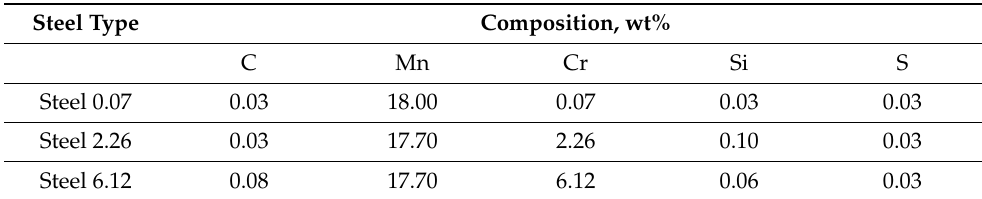
Table 1. Chemical compositions of the examined steels